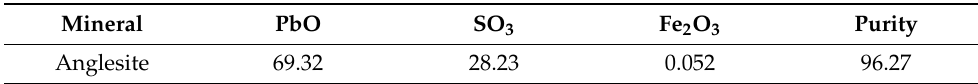
Table 3. Chemical composition of pure anglesite mineral (wt %).